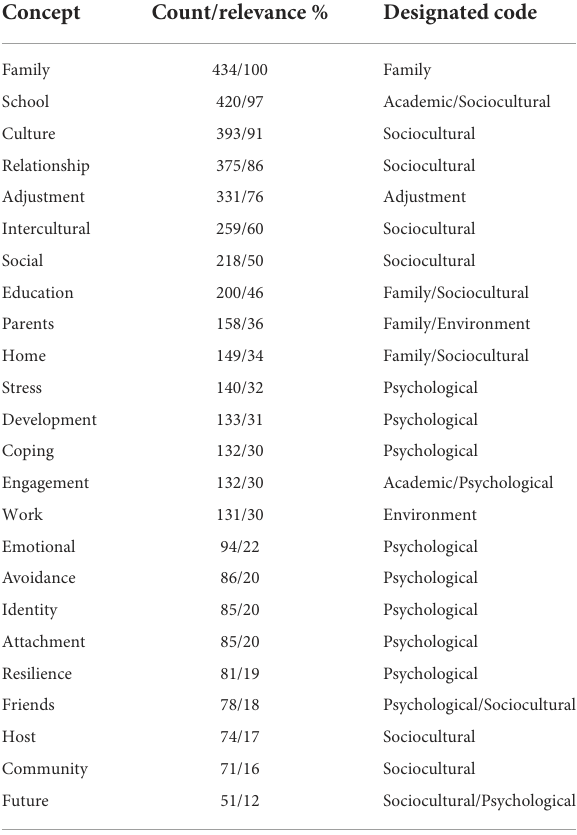
TABLE 2 Coded Leximancer ranked concept